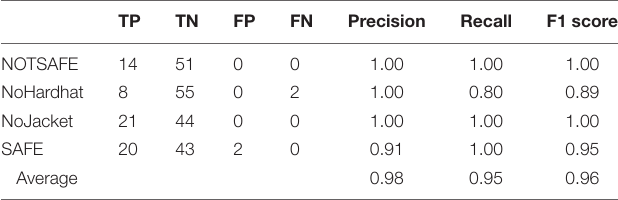
TABLE 7 | Classification report for the novel